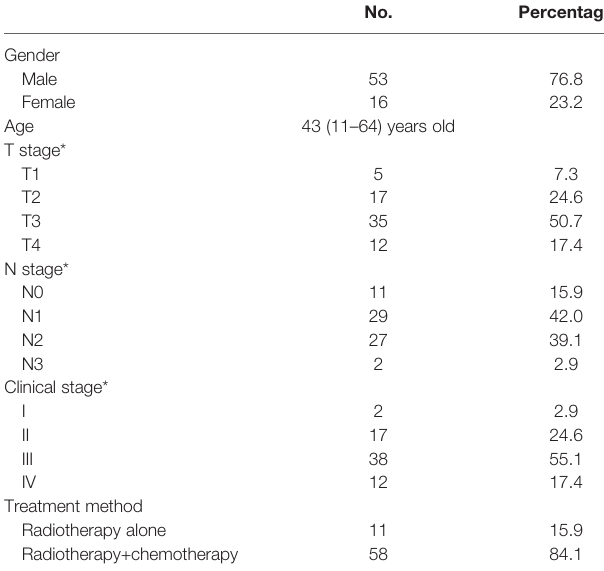
TABLE 1 | Patient and treatment